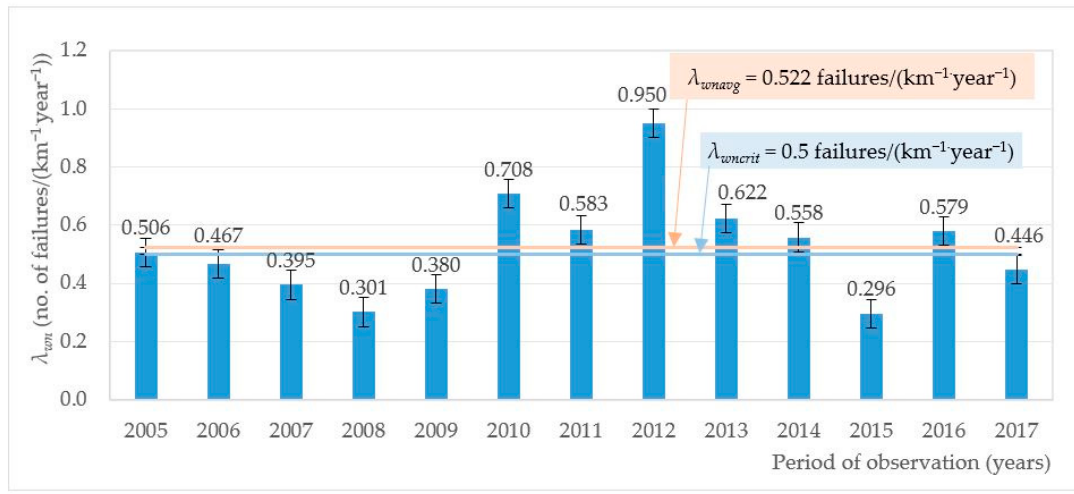
Figure 2. The failure rate for the whole network over the distinguished 2005–2017 time period.